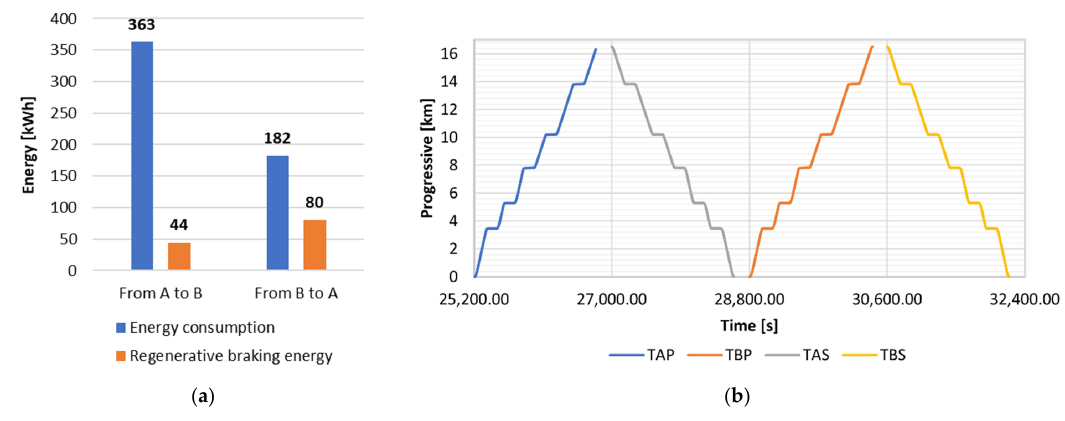
Figure 14. Energy required by trains: ( a ) Energy data; ( b ) Traffic conditions of the railway line.